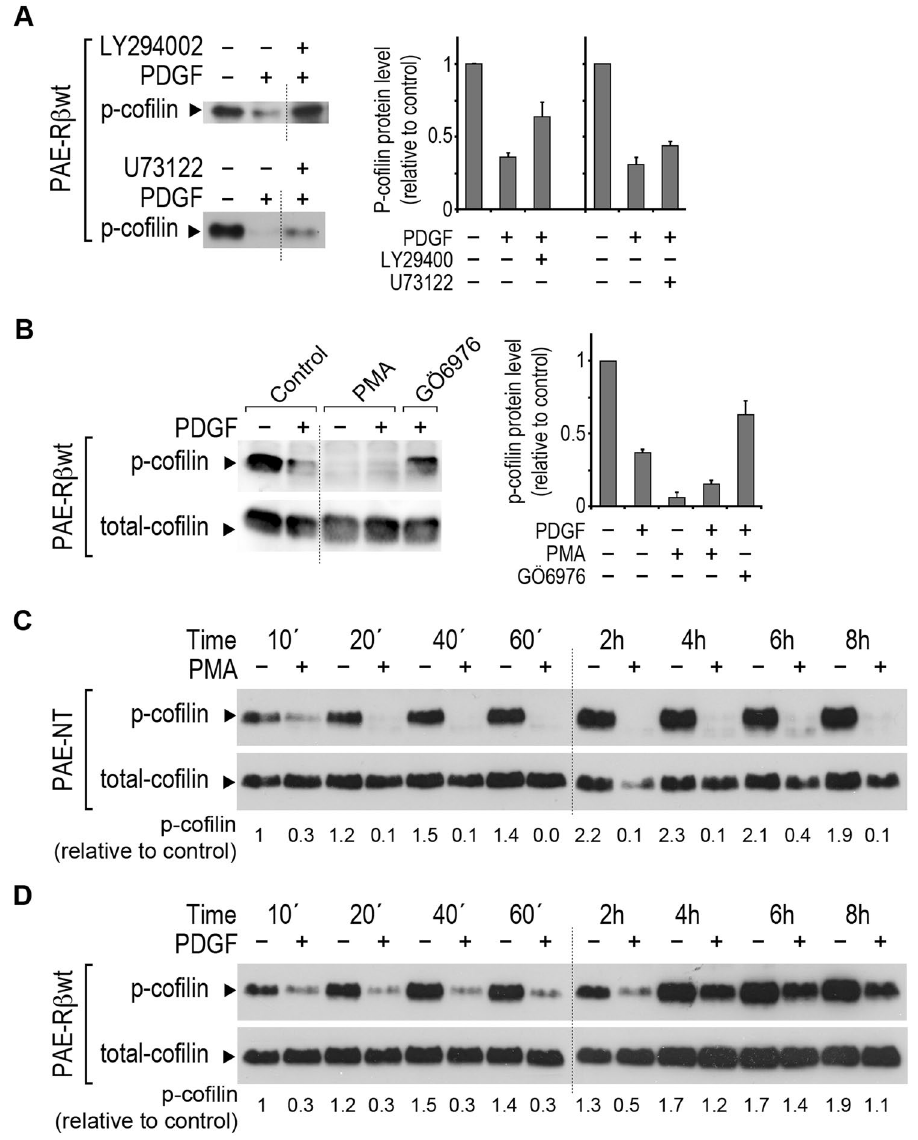
Figure 5. Inhibition of PI3K, PLC γ , and PKC inhibits PDGF-induced cofilin dephosphorylation. ( A ) Representative immunoblot of p-cofilin protein level in PAE-R β wt cells after pre-treatment for 1 h with LY294002 (50 μ M) or U73122 (10 μ M), in the presence or absence of PDGF-BB (15 min stimulation). The quantified values are averaged from three independent experiments. ( B ) The effect on p-cofilin protein level by pre-treatment of PAE-R β wt cells with the PKC inhibitor GÖ6976 (1 μ M) 15 min after stimulation with PDGF-BB (20 ng/mL). The p-cofilin protein level was also quantified 15 min after stimulation of PAE-R β wt cells with PMA in the presence or absence of PDGF-BB. The total protein level of cofilin (total-cofilin) was quantified as an internal control. The quantified values are normalized to the total-cofilin protein level, and relative to the control condition. ( C ) The protein level of p-cofilin and total-cofilin during 8 h stimulation of non-transfected PAE cells (PAE-NT) with PMA. ( D ) The protein level of p-cofilin and total-cofilin during 8 h of stimulation of PAE-R β wt cells with PDGF-BB. In all panels shown data are representatives of at least three individual experiments. In panels (C and D) the quantified values are calculated as the ratio of p-cofilin band to total cofilin band and are presented below the corresponding bands. The hashed line in panels (A and B) show where the blot was cut to take away other tested conditions from the same blot. The hashed line in panels (C and D) show where two separate blots were placed next to each other to present the entire set of samples taken during the 8 h experiment together. The full-length copies of all the blots used in this figure are presented in supplementary